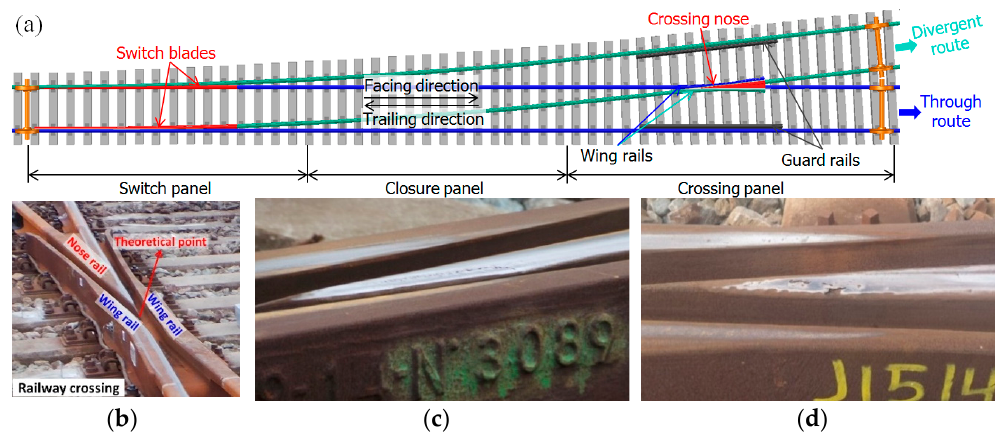
Figure 1. ( a ) Standard left-hand railway turnout with a 1:9 crossing (drawn by X. Liu); ( b ) crossing panel on site (shot by V.L. Markine); ( c ) plastic deformation with cracks (shot by X. Liu); ( d ) spalling (shot by X. Liu).